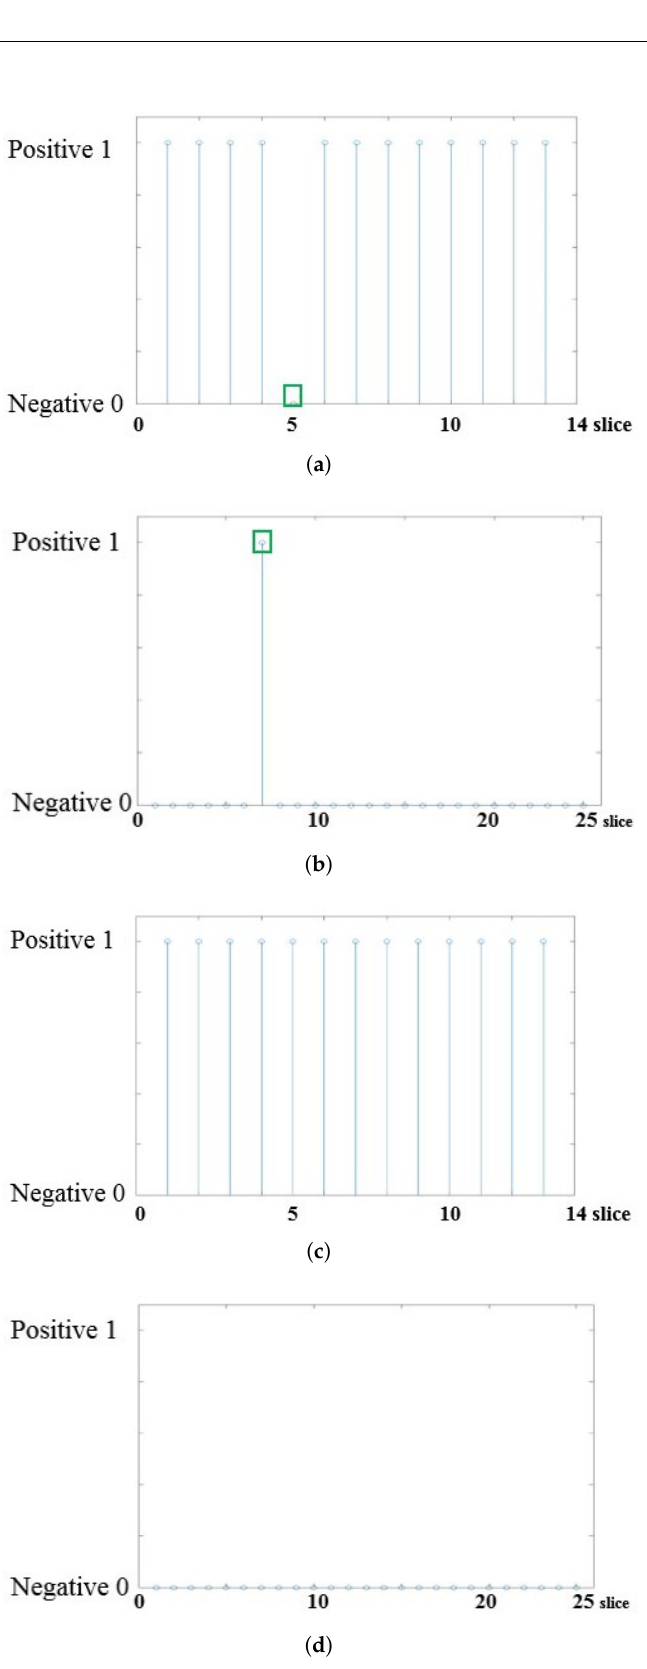
Figure 6. Results of automatically determining the presence of bone marrow edema using ResNet. ( a ) Results for axSpA subjects; ( b ) results for normal subjects; ( c ) results of applying the median filter to the results of ( a ); ( d ) results of applying the median filter to the results of ( b